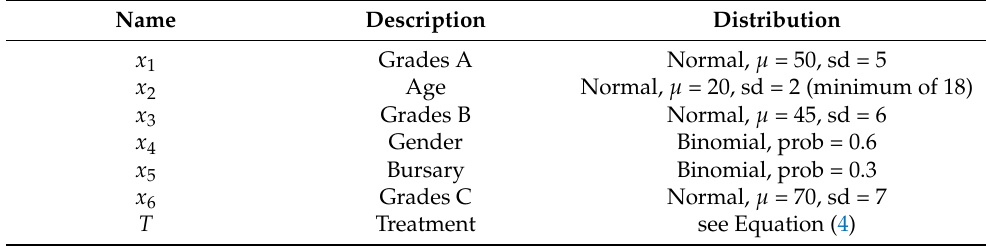
Table 1. Description of generated